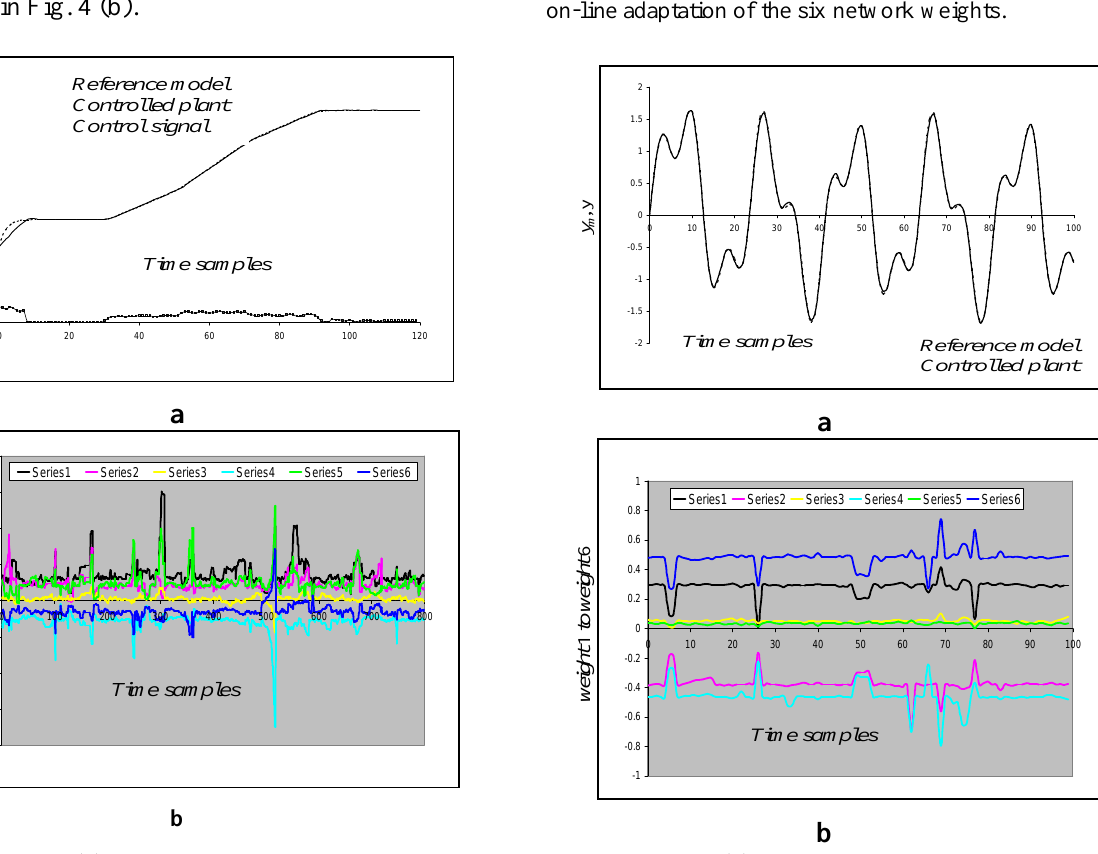
Fig. 4. Plant 2 (a) outputs of the reference model and the controlled plant (b) on-line .